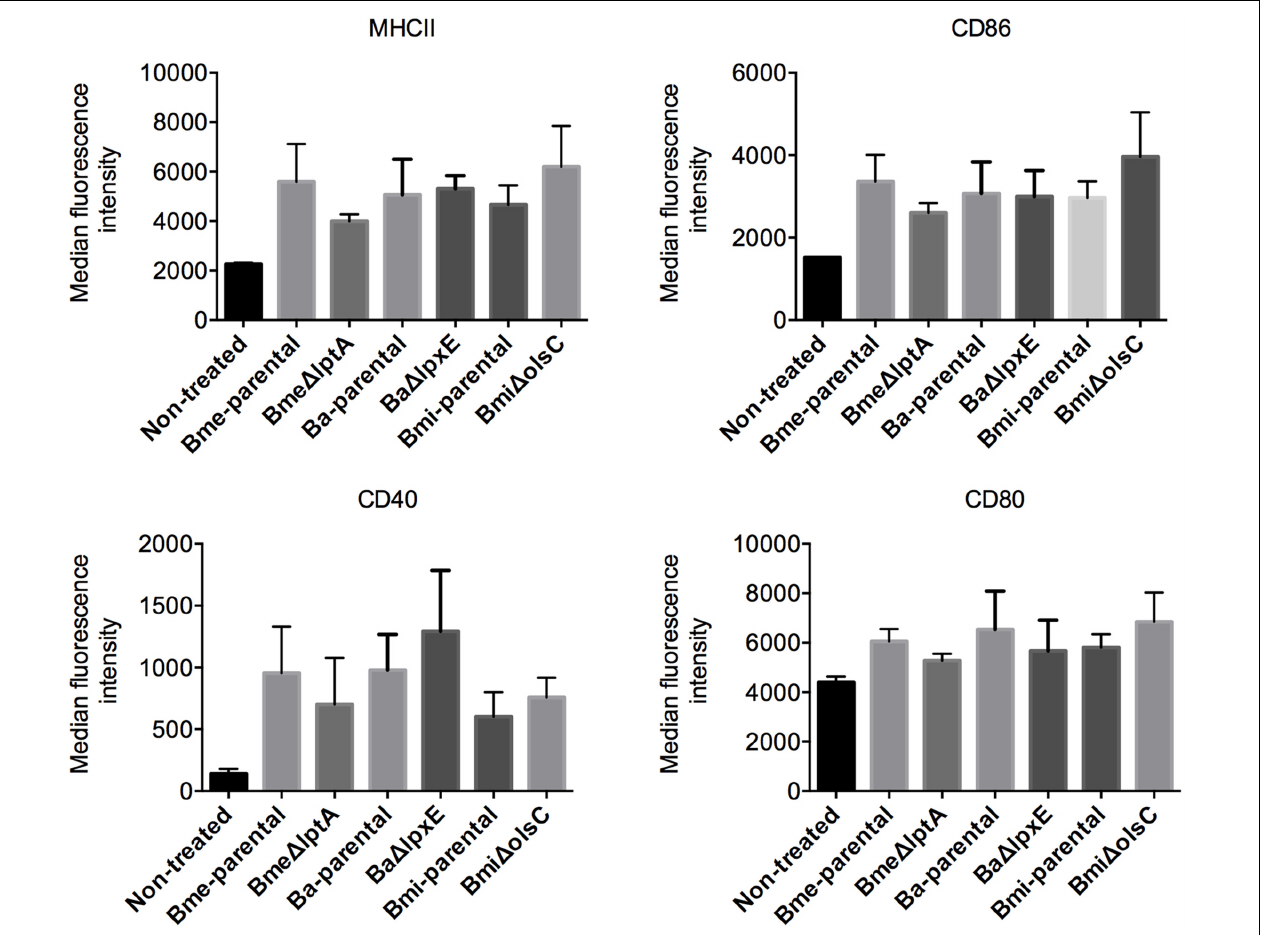
FIGURE 5 | LptA, LpxE, and OlsC deletions do not significantly impact the intrinsic immunogenicity of Brucella . Each point represents the mean ± standard error of the median intensity of surface receptor expression in dendritic cells treated with Brucella strains or derived mutants. E. coli LPS was used as a positive control for dendritic cell